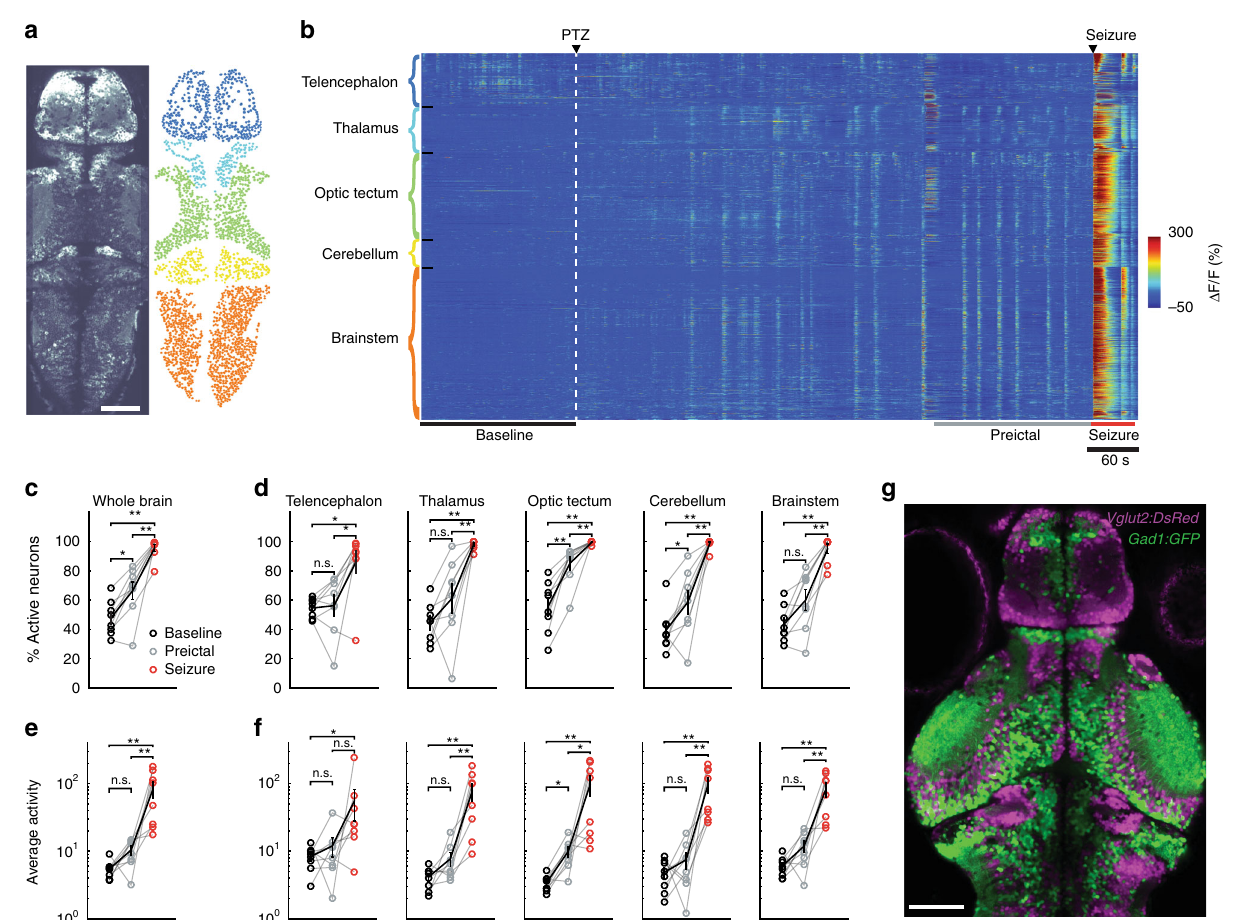
Fig. 2 Brain regions are differentially recruited during epileptic activity. a An optical section of a zebra fi sh larva expressing GCaMP6s in all neurons, obtained by two-photon microscopy, dorsal view (left). Individual neurons (right) in color-coded brain regions: telencephalon (dark blue), thalamus (light blue), optic tectum (green), cerebellum (yellow), and brainstem (orange). b Activity of individual neurons ( Δ F/F) over time, organized by brain region. White dashed line indicates the start of 20 mM pentylenetetrazole (PTZ) perfusion. Warmer colors indicate stronger activity. c , d Percentage of active neurons (>3std baseline ) in the whole brain ( c ), and per brain area ( d ) during baseline (black), preictal (gray) and seizure periods (red). e , f Average activity of the active neurons, de fi ned by the area under the curve of the Δ F/F trace, in the whole brain ( e ) and per brain area ( f ). g Confocal image of Tg(gad1:GFP) ; Tg(vglut2a:dsRED) double transgenic zebra fi sh larva showing glutamatergic (magenta) and GABAergic (green) neurons. White bars re fl ect 100 µ m. ** p = < 0.01, * p = < 0.05, ns = not signi fi cant, Wilcoxon signed-rank test. Error bars ( c-f ) represent the s.e.m. of n = 8 fi sh, where 2012.6 ±